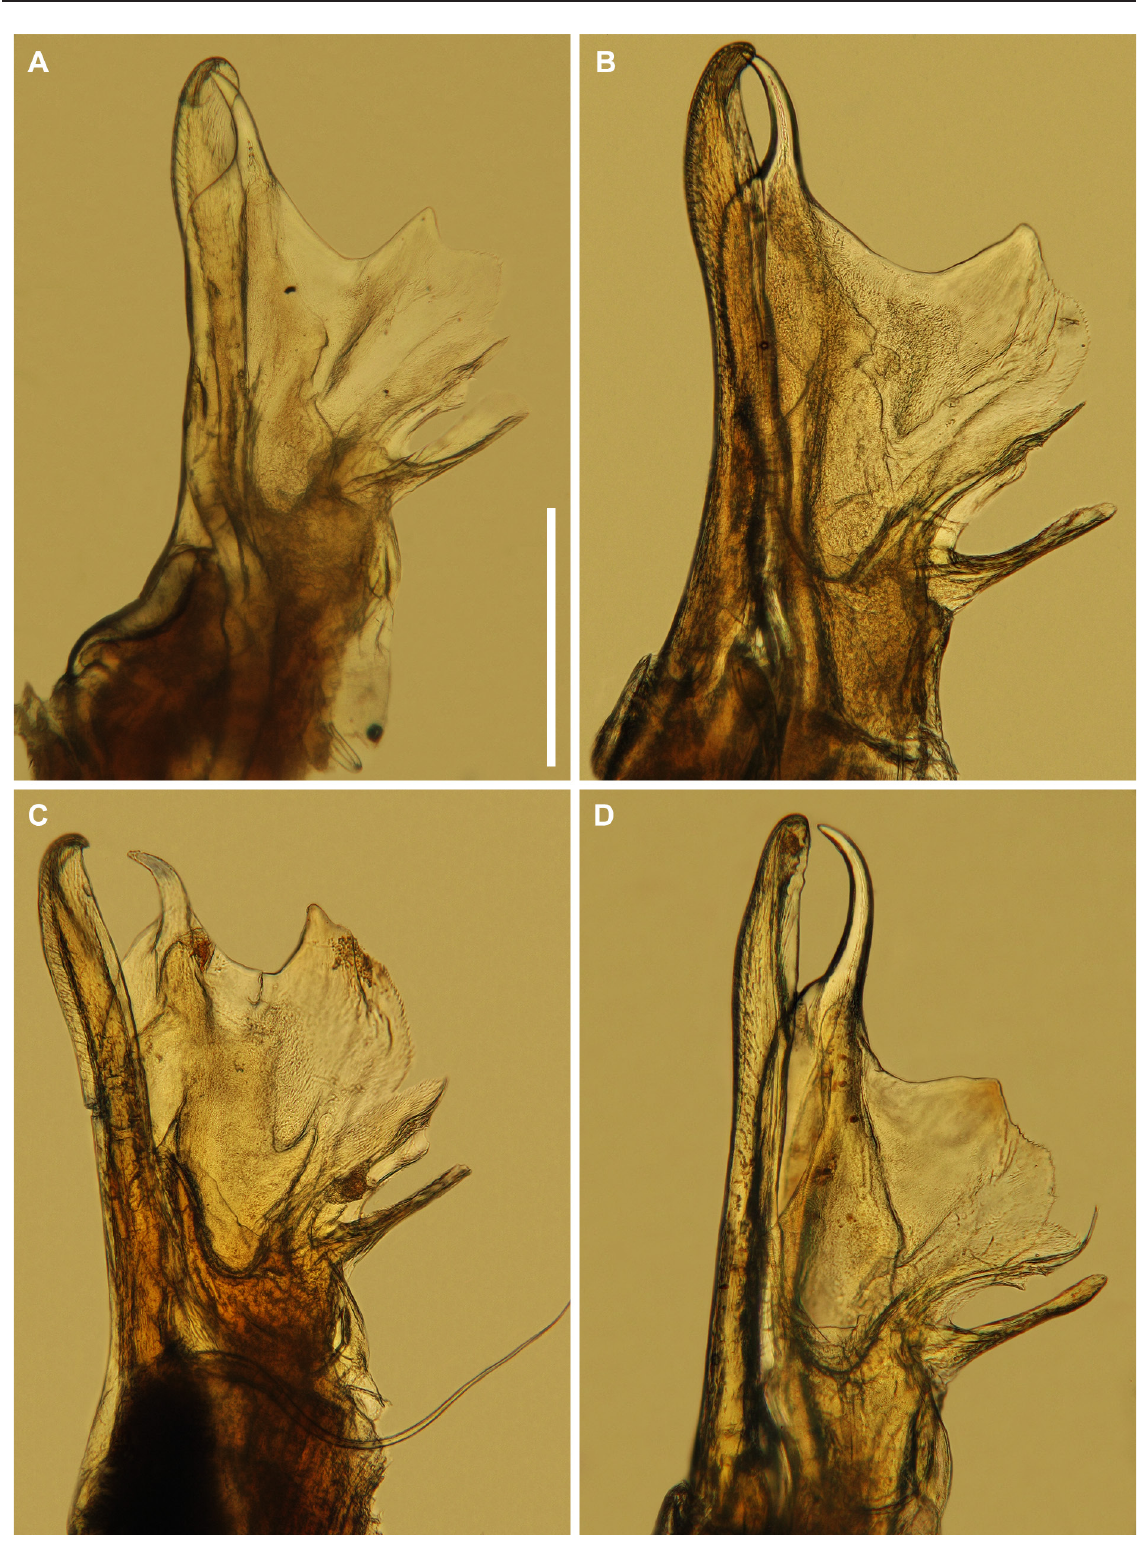
Fig. 27. Gonopods (A–C: Leucogeorgia lobata sp. nov.; D: L. aff. lobata sp. nov., ♂ from Eckis Cave). A . Paratype ♂ from Garakha Cave, right gonopods, lateral view (IZISU). B . ♂ from Motena Cave, left gonopod, mesal view (SMNG). C . ♂ from Motena Cave, left gonopod, mesal view (ZMUM). D . Left gonopod, mesal view (SMNG). Scale bar: 0.3